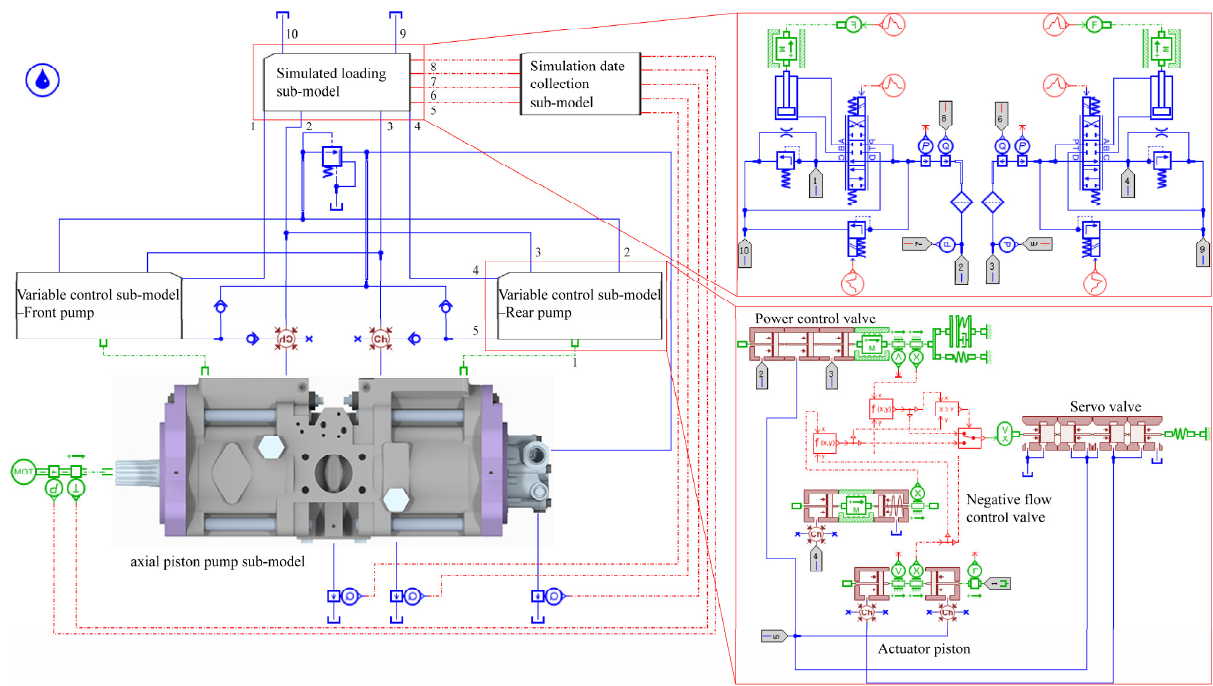
Figure 9. Numerical simulation model of the double-compound axial piston pump.